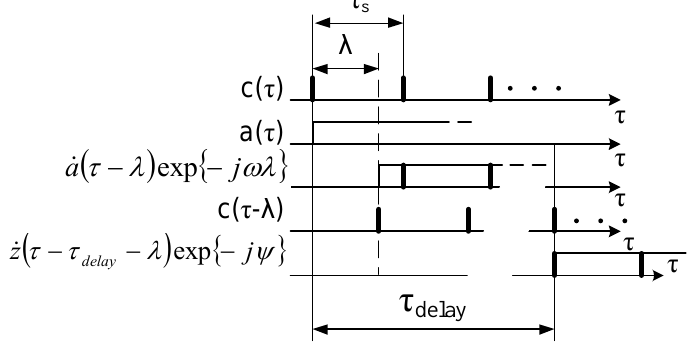
Fig. 1. The cycle diagram of the formation of the return signal with synchronization from the sounding